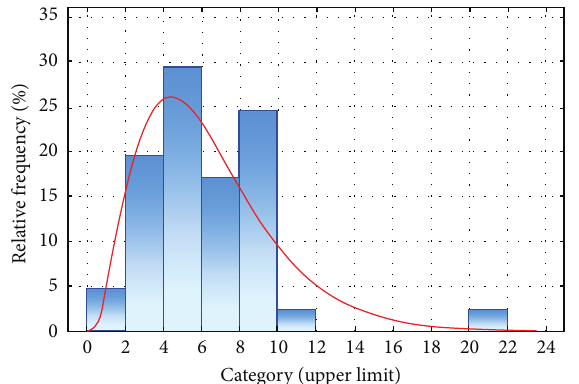
Figure 8: Gamma distribution for mass loss.